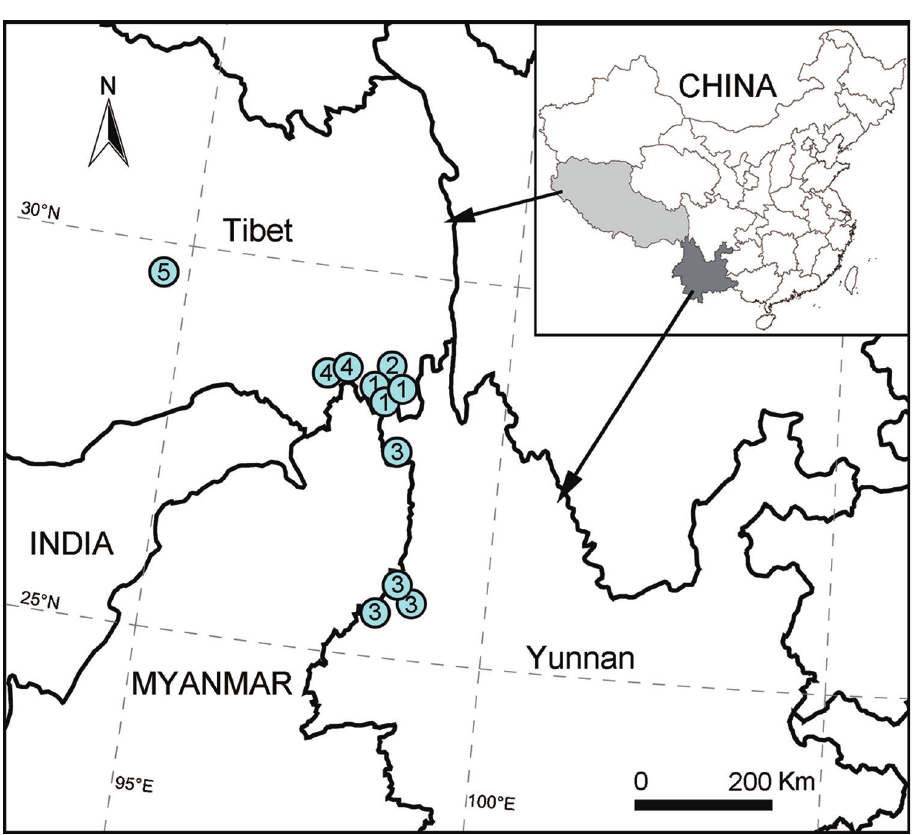
Figure 11. Localities of Sinodraconarius species in the Southwest China. 1 S. cawarongensis sp. n. 2 S. muruoensis sp. n. 3 S. patellabifidus 4 S. sangjiuensis sp. n. 5 S. yui sp. n.